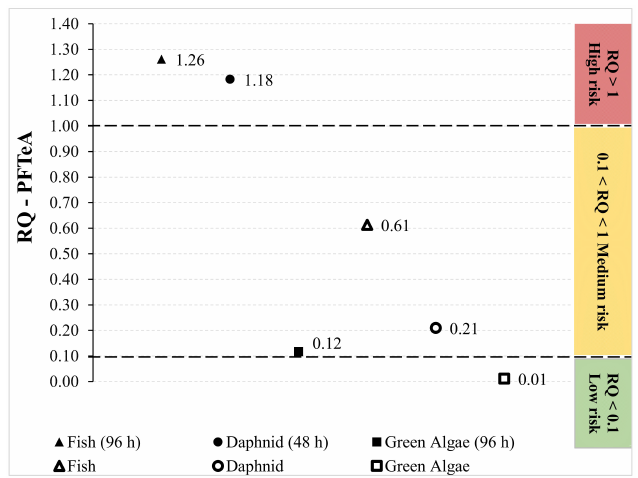
Figure 2. Risk assessment of the higher detected concentration of PFTeA (i.e., Antu ã river at SP3 in dry season). The different symbols represent the RQ values for the different organisms and types of toxicity (acute—bold symbols and chronic—open symbols). Table 1. Toxicity data of target PFAS compounds (type of effect, organism, and concentration), predicted no-effect concentration (PNEC), risk quotient and the respective classification